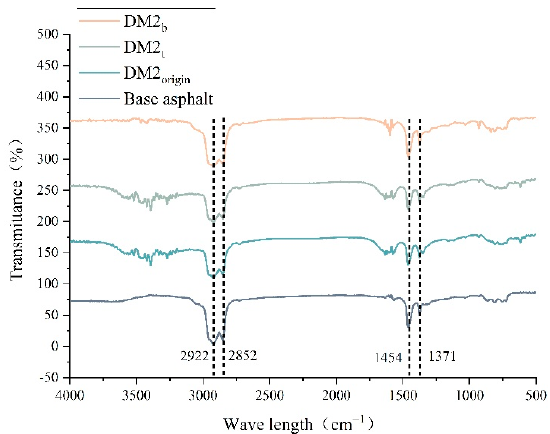
Figure 10. FTIR spectra of DM-modified asphalt.